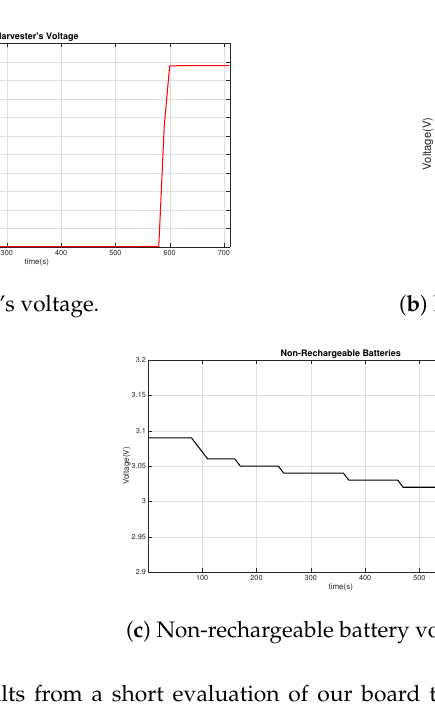
Figure 13. Results from a short evaluation of our board to demonstrate the robust switch from harvesters to non-rechargeable batteries and vice